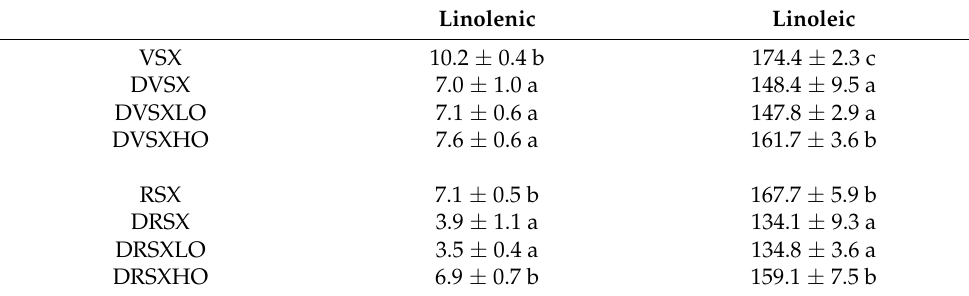
Table 2. Concentrations of the two kinds of polyunsaturated acyl groups+fatty acids (AG + FA), expressed in mmol/mol AG + FA, present in the oxidized virgin and refined soybean oil samples (VSX and RSX) and in their digestates (DVSX and DRSX), as well as in the digestates of VSX and RSX samples mixed with two different levels of ovalbumin: 26% in weight (DVSXLO and DRSXLO) and 260% in weight (DVSXHO and DRSXHO). Different letters within each column indicate a significant difference among the samples corresponding to the same type of oil ( p <